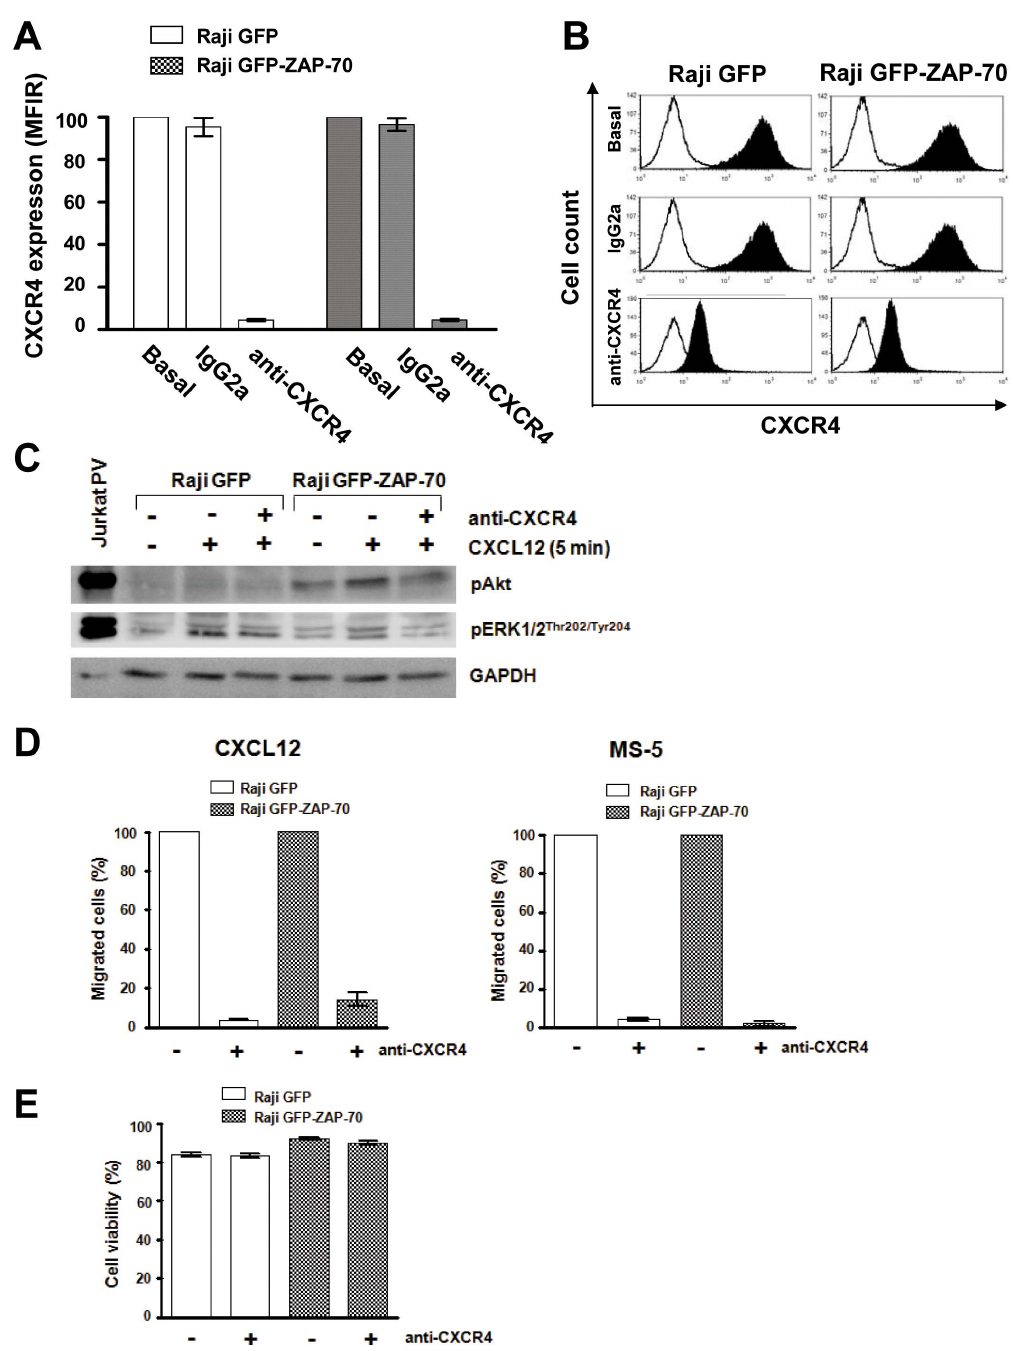
Figure 6. Anti-CXCR4 antibody reduces CXCR4 surface expression, and blocks migration toward CXCL12 and BMSCs. (A) Relative MFIR of CXCR4 surface staining after incubation of Raji transfectants with 100 m g/mL of anti-CXCR4 antibody for 30 minutes. (B) Flow cytometry histograms showing the reduction in CXCR4 expression after incubation with neutralizing anti-CXCR4 antibody. White histograms represent negative unstained controls. (C) CXCR4-blocked cells were stimulated with 100 ng/mL of CXCL12 for 5 minutes and activation of Akt and ERK1/2 proteins analyzed by western blotting. (D) CXCR4-blocked cells were subjected to migration assay for 4 hours at 37 u C in 5% CO 2 toward 100 ng/mL of CXCL12 (left panel) or the stromal MS-5 cell line (right panel). Cells in the lower chamber were counted by flow cytometry under a defined flow rate for 5 minutes. Number of migrated cells treated with isotypic control was considered 100%. Results are shown as the mean 6 SEM of 4 independent experiments. (E) Cell viability was measured by Annexin V-PI staining in cells incubated with 100 m g/mL of anti-CXCR4 or isotypic control for 48 hours. Results are shown as the mean 6 SEM of 4 independent experiments